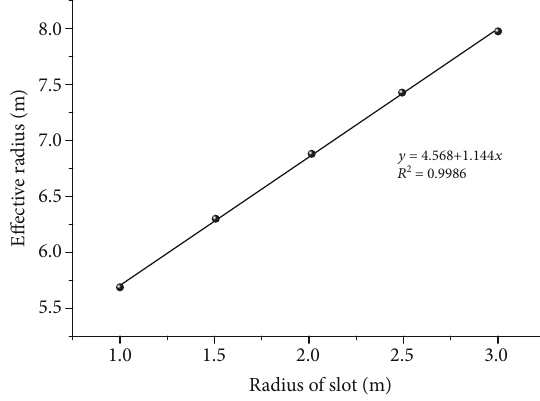
Figure 11: Relationship between slot radius and e ff ective radius.